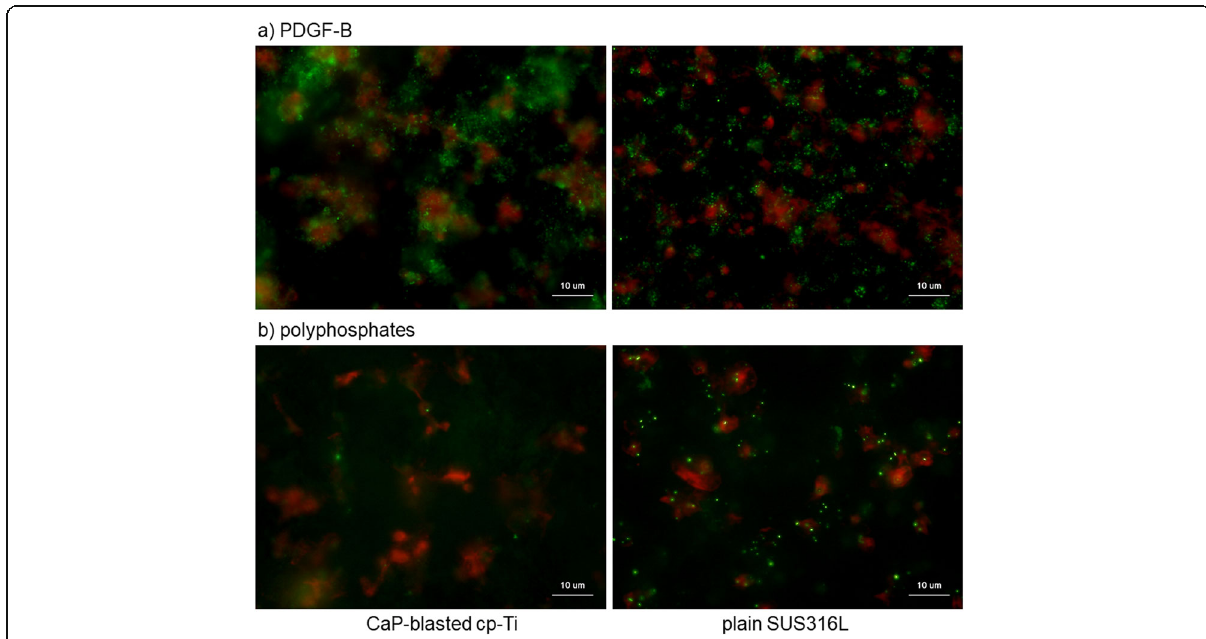
Fig. 10 a Immunocytochemical visualization of PDGF-B and b chemical detection of polyphosphates. CaP-blasted cp-Ti and plain SUS316 plates were incubated with PRP for 60 min, washed, fixed, and subjected to immunocytochemical or chemical detection. Green represents proteins reactive for PDGF-B ( a ) or polyphosphates ( b ), while red represents polymerized